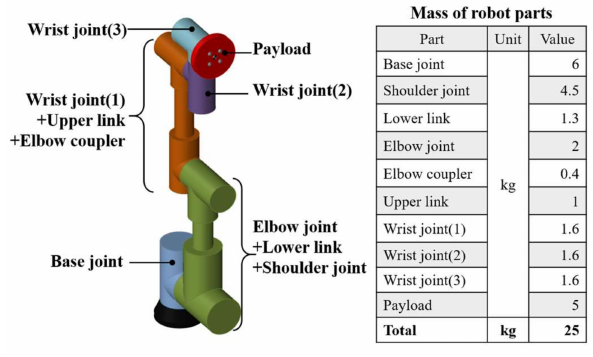
Figure 6. Simplified 3D analytical model of robot.